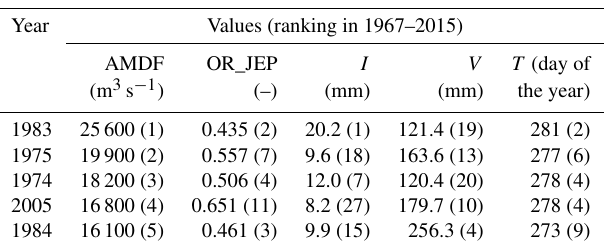
Table 8. Summary of the rainfall information for the five largest floods after the construction (1967) of the Danjiangkou Reservoir in the HZ